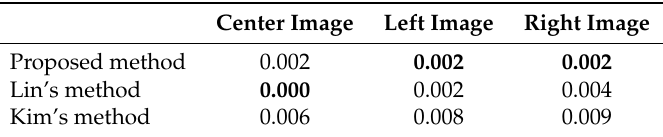
Table 5. Average BER of DIBR